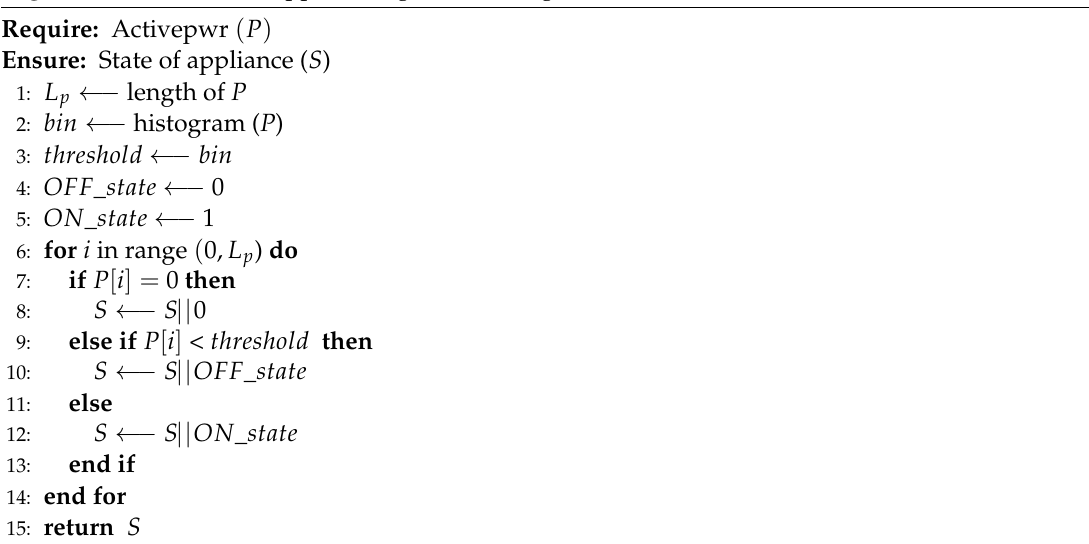
Algorithm 2 State of the appliances generation